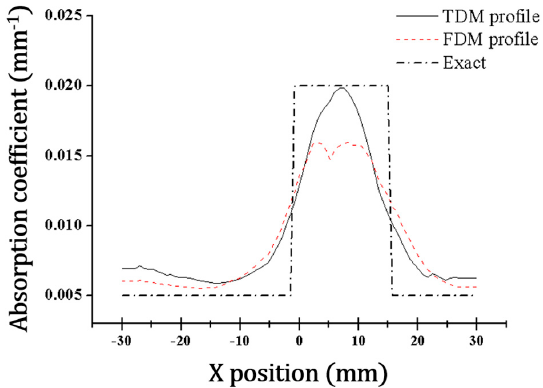
Figure 5. Cross sectional profiles of the phantom absorption coefficients along horizontal dotted lines in Figure 4. The black dash-dot line represents the actual phantom absorption coefficient profile. The black solid and red dashed lines represent the estimated absorption coefficient profiles recovered by the TDM DOT and FDM DOT systems, respectively.